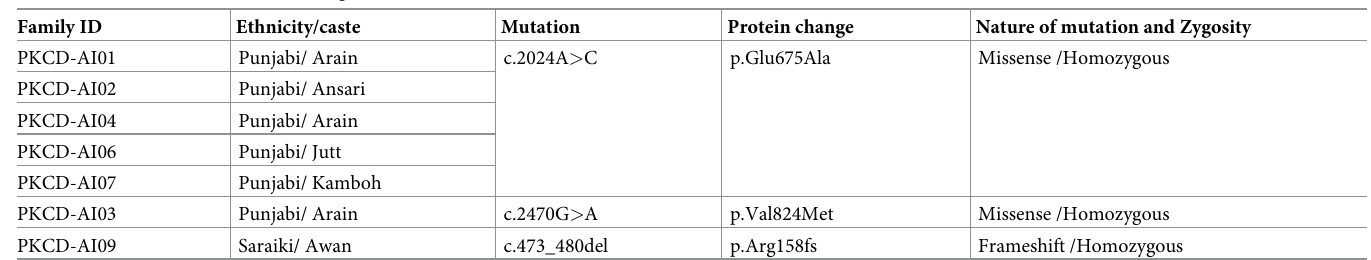
Table 1. Mutations found in SLC4A11 gene from residents of Pakistani families.